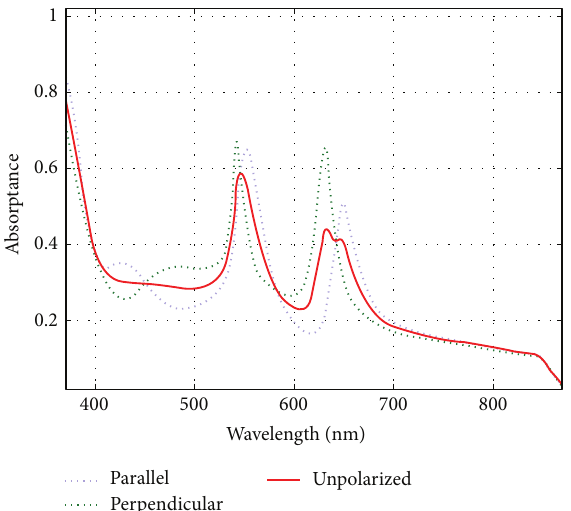
Figure 2: Calculated absorptance spectra for an optimized ( FF = % 50, h = 130nm, and a = 300 nm) solar cell structure with a 130nm-thick GaN cap layer and a 20 nm-thick InGaN layer in the case of parallel (blue dotted), perpendicular (green dashed) polarizations with respect to the photonic crystal pattern, and unpolarized light incidence (solid red).